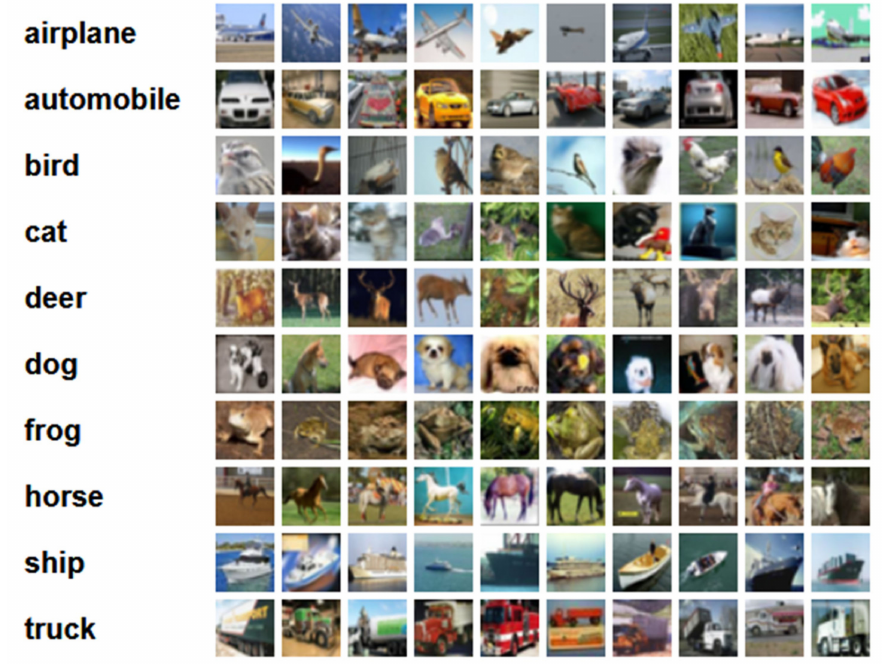
Figure 2. CIFAR-10 data set sample